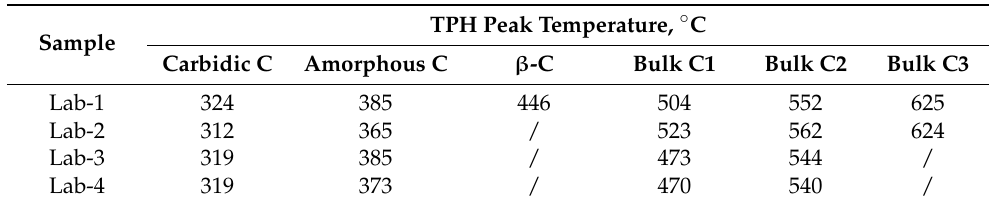
Table 3. Relative contents of carbonaceous species calculated from the corresponding peak area of Gaussian fitting of H 2 -TPH patterns over the catalysts with a different potassium loading.